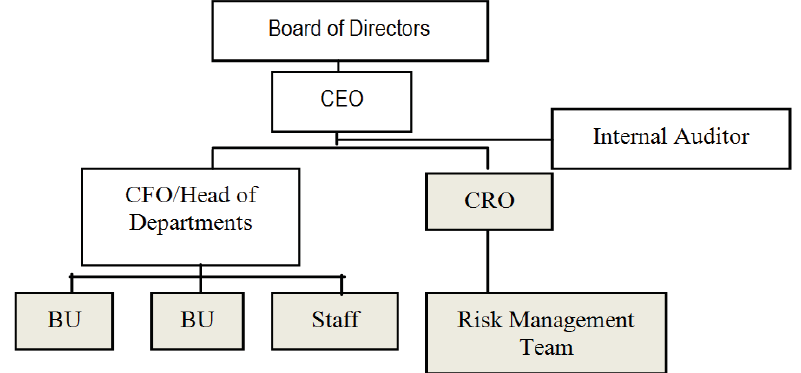
Fig. 3. Risk governance system in